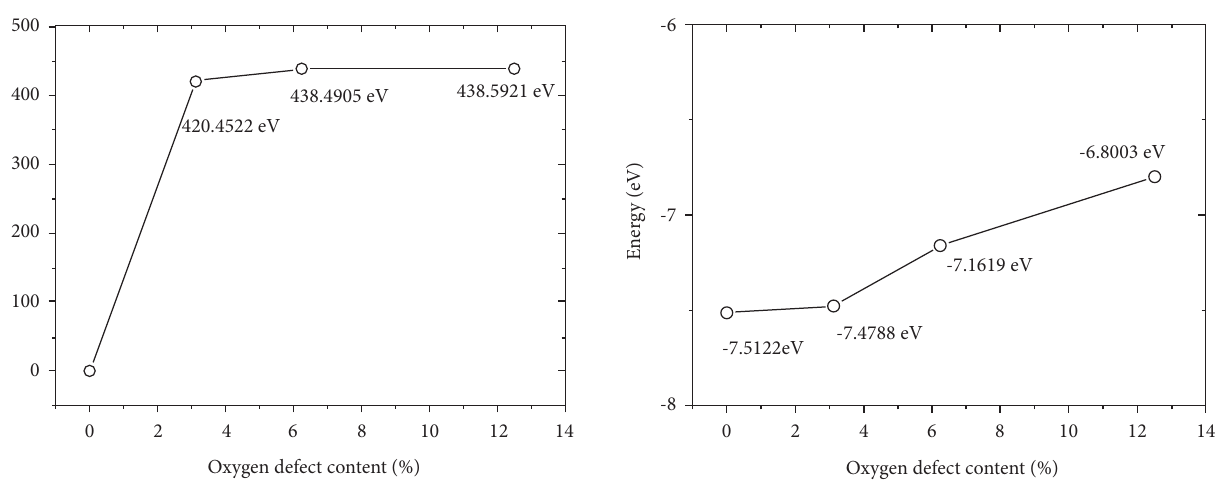
f for the TiO 2 system as